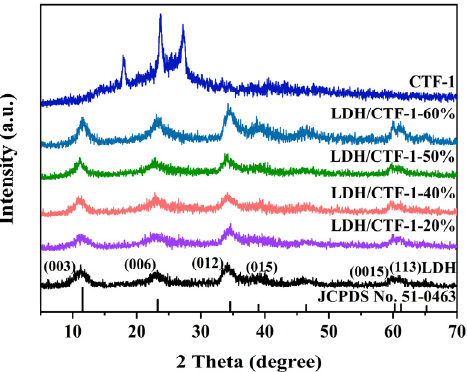
Figure 1. XRD patterns of pure LDH, CTF-1, and the LDH/CTF-1 nanocomposites.